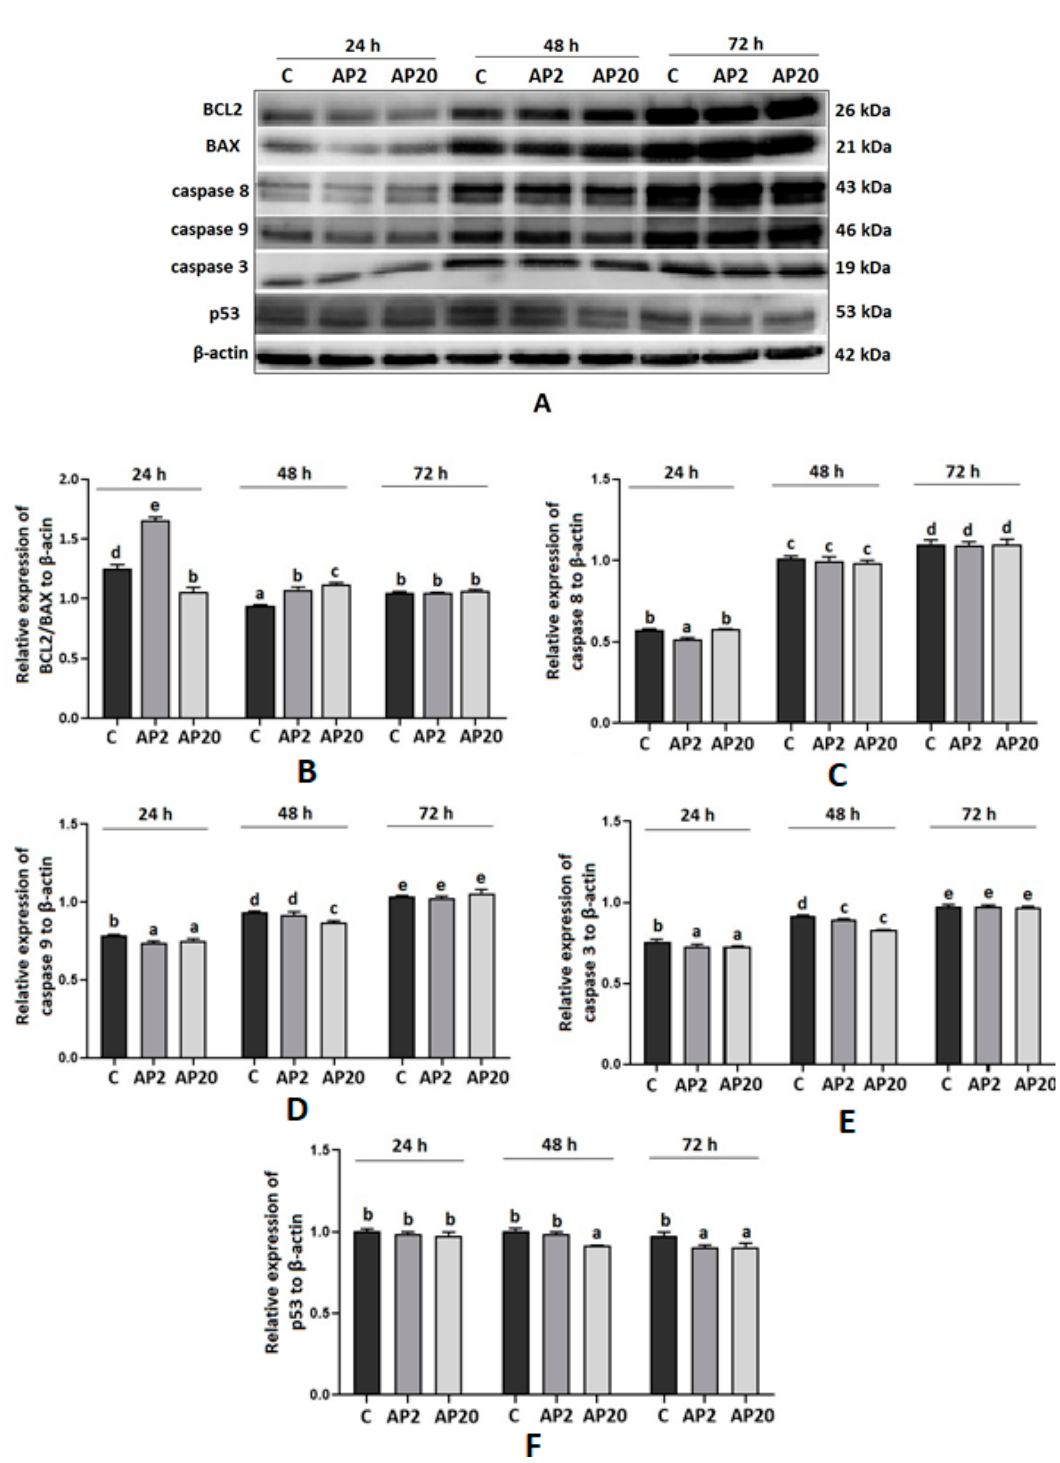
Figure 1. Effect of apelin on protein expression of apoptotic factors in BeWo cells. The cells were incubated with apelin at doses 2 of (AP2) and 20 (AP20) ng/mL for 24, 48 and 72 h, and subsequently, Western blot analysis was performed to examine the expression of BCL2 (B-cell like lymphoma 2), BAX (Bcl-2-like protein 4), caspase 3, 8 and 9 and p53. Results are shown as stripes on gel image ( A ) and densitometry analysis relative to β -actin ( B – F ). Experiments were independently performed and repeated three times ( n = 3). The data are arranged as means ± SEM. Different letters indicate significant differences ( p < 0.05) among groups; Control ( C ).